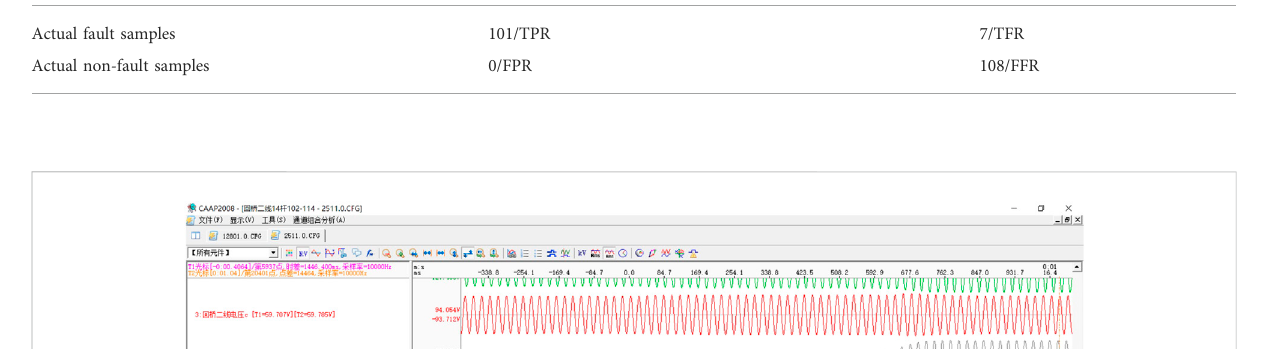
TABLE 3 AdaBoost confusion